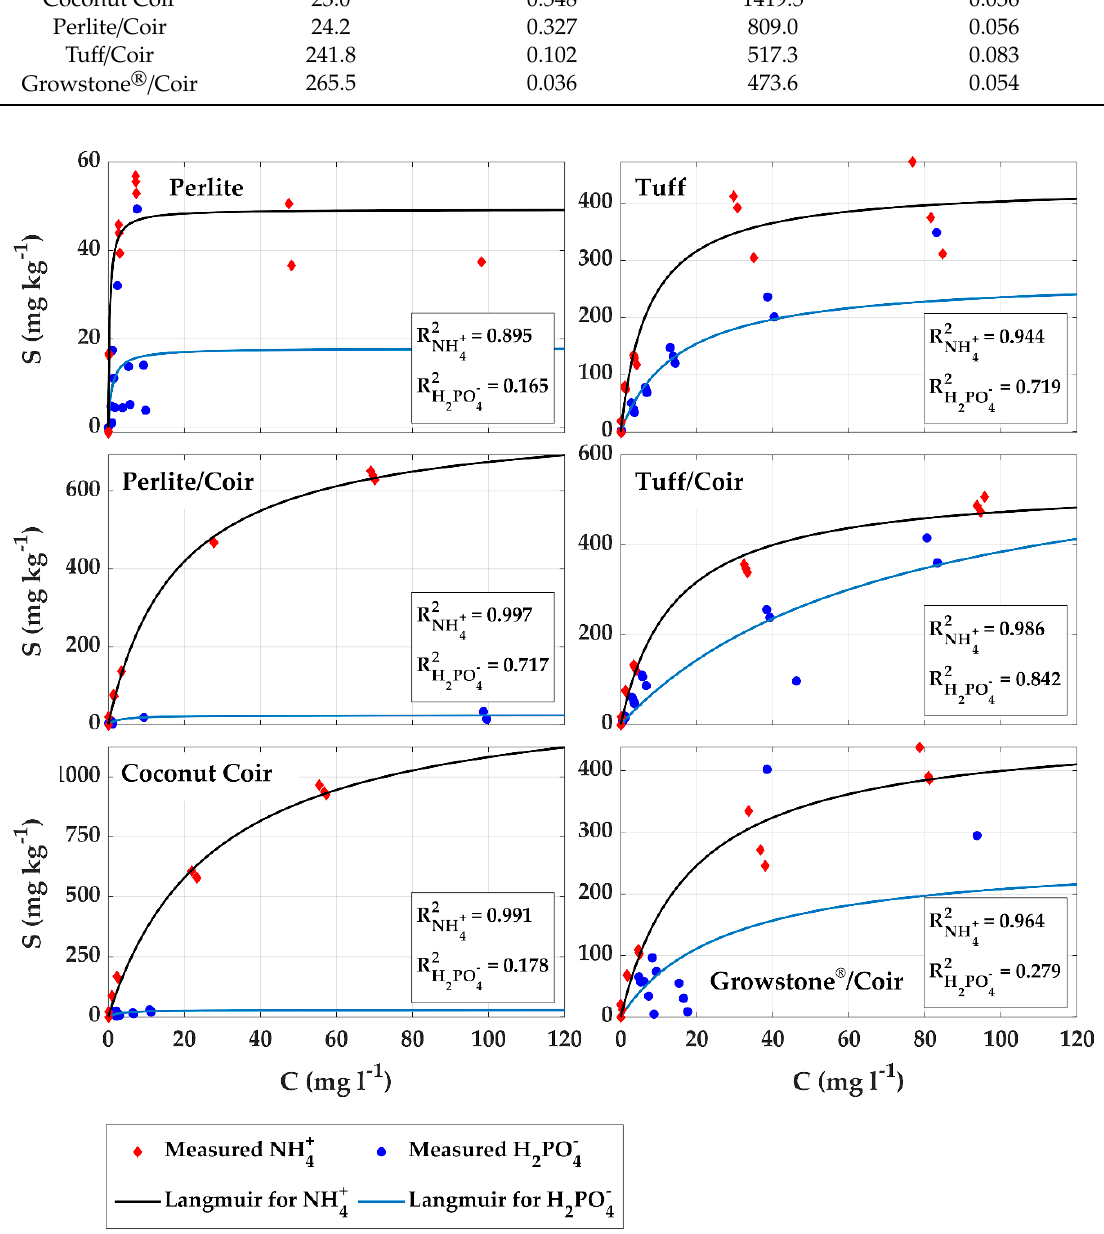
Figure 5. Measured (cid:1840)(cid:1834) (cid:2872)(cid:2878) and (cid:1834) (cid:2870) (cid:1842)(cid:1841) (cid:2872)(cid:2879) equilibrium concentrations displayed with the fitted Figure 5. Measured NH 4 + and H 2 PO 4 − equilibrium concentrations displayed with the fitted Langmuir Langmuir adsorption isotherms and the associated coefficients of determination. adsorption isotherms and the associated coe ffi cients of